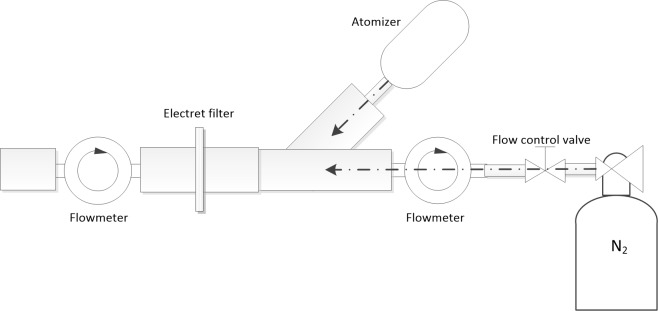
Schematic diagram of experiment setup used in this study.